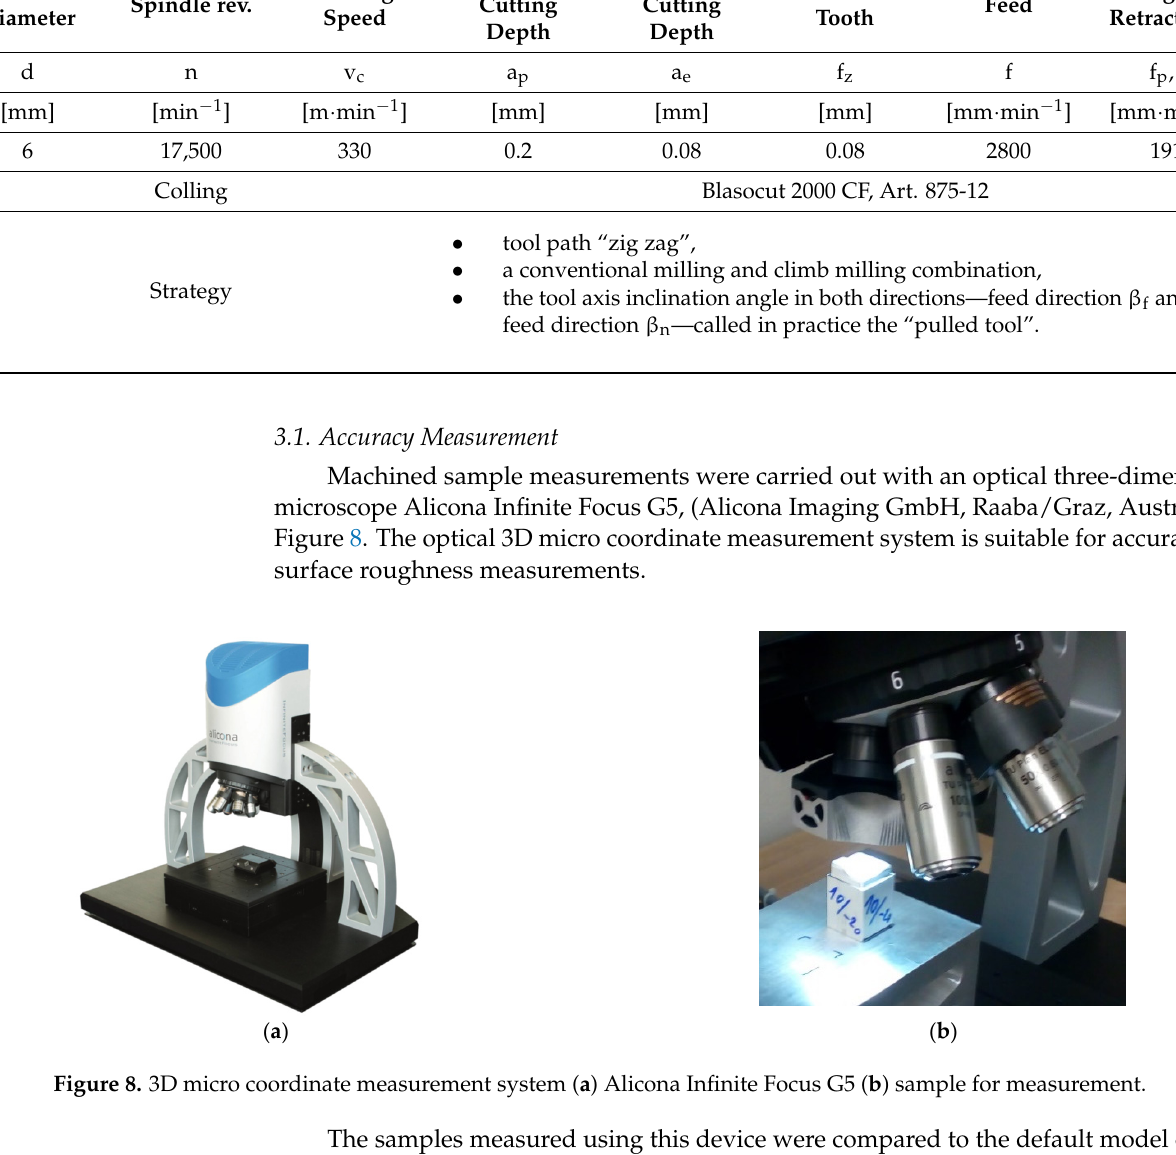
Figure 9. An example of the result of the scanned surface of a single sample on a Alicona Infinite Focus G5 ( a ) 3 + 2 mill- ing, tool axis inclinations β f = 5°, β n = 10°, ( b ) red square area (4 mm × 4 mm) for surface roughness measurement.